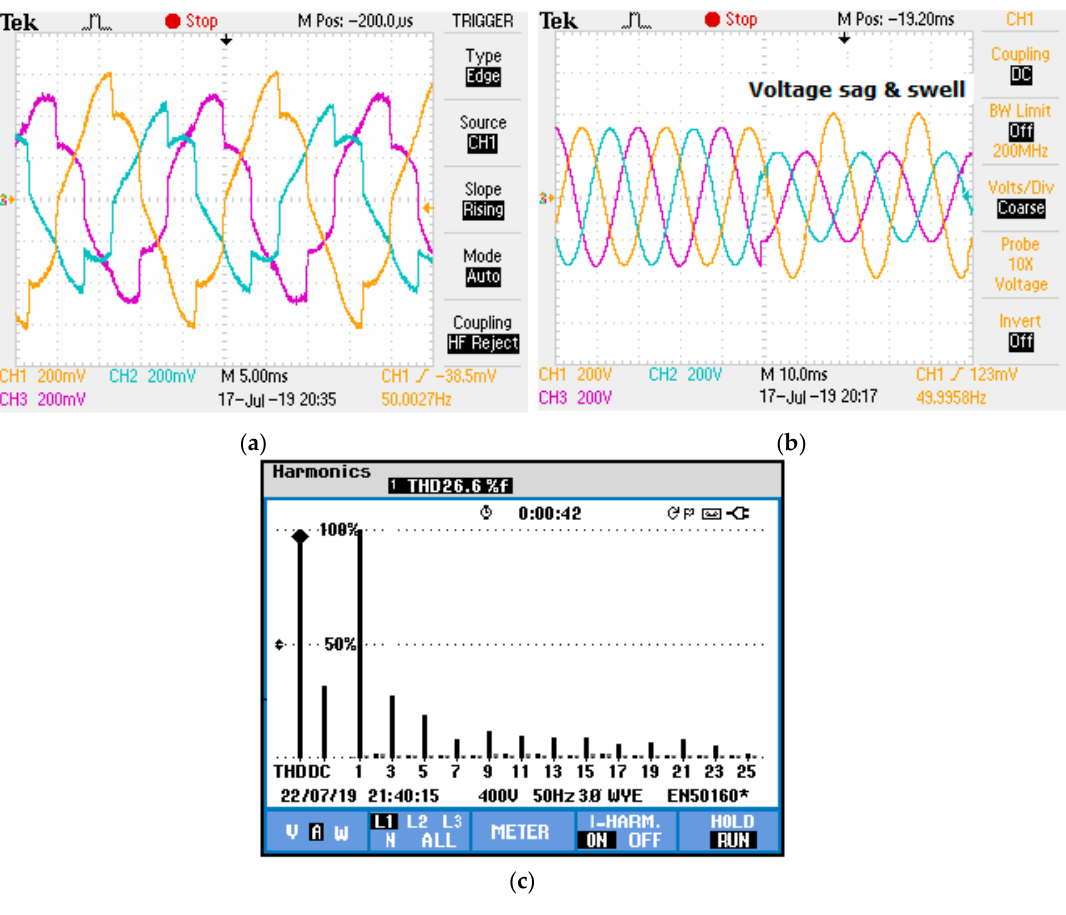
Figure 26. Experimental test results under unbalanced voltages with unequaled load currents: (a) unbalanced load currents; (b) unbalanced source voltages; and (c) harmonic distortions before the solar photovoltaic-unified power quality conditioner connection. Experimental results in unbalanced voltages with unbalanced load currents are shown in Figure 27: (a) shunt active power filter injected current; (b) source current; (c) injected series active power filter voltage; and (d) harmonic distortion after solar photovoltaic-unified power quality conditioner connection.